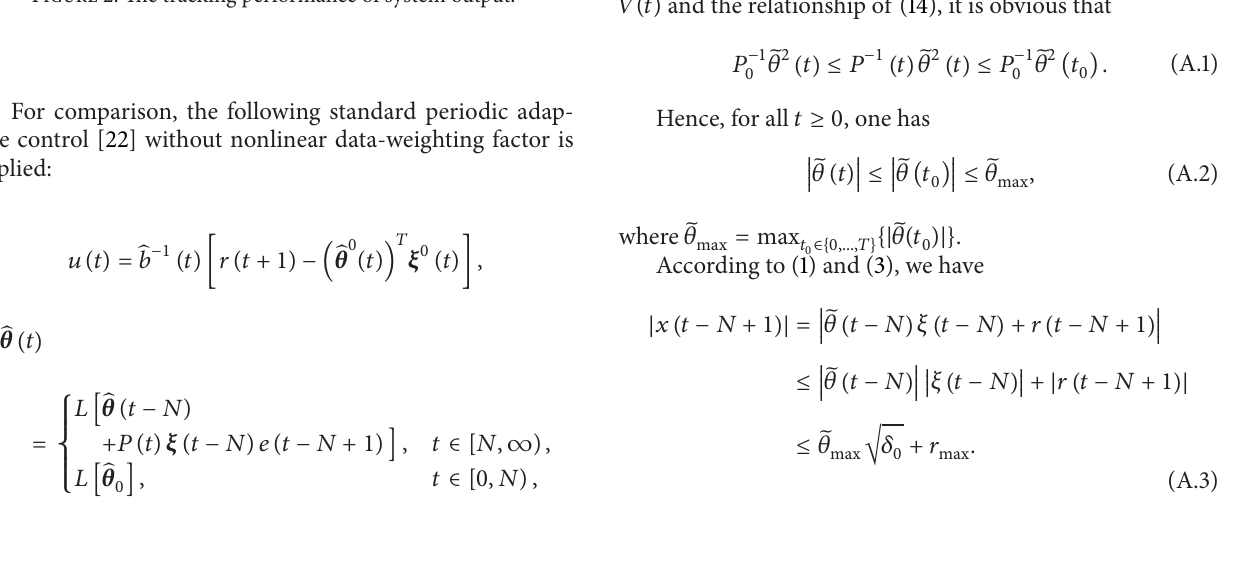
Figure 2: The tracking performance of system